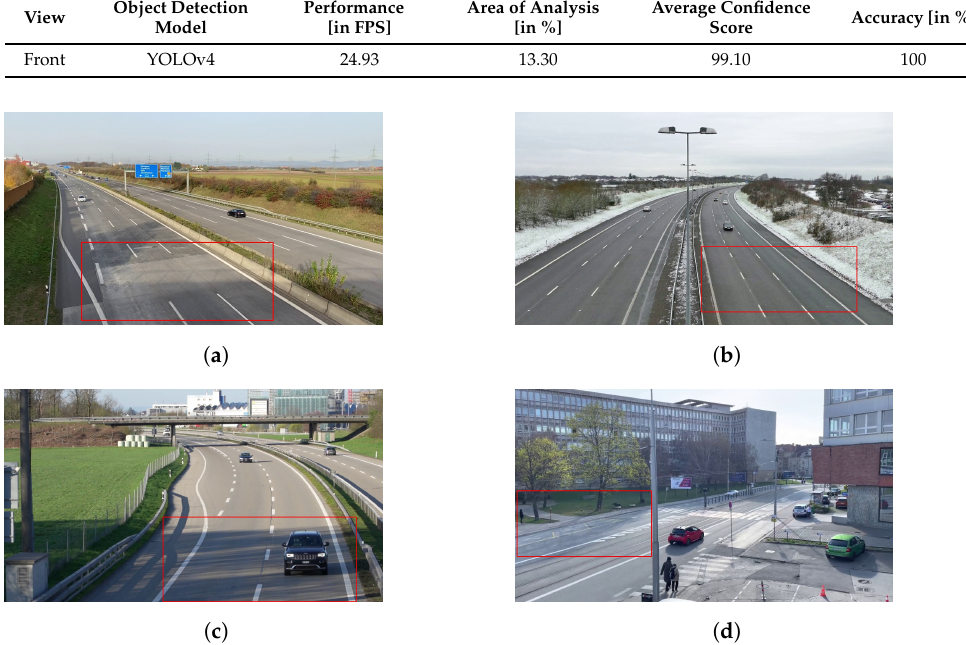
Figure 13. Set of testing scenarios. ( a ) Front view of Sample scenario #3; ( b ) front view of Sample scenario #4; ( c ) front view of Sample scenario #5; ( d ) front view of Sample scenario